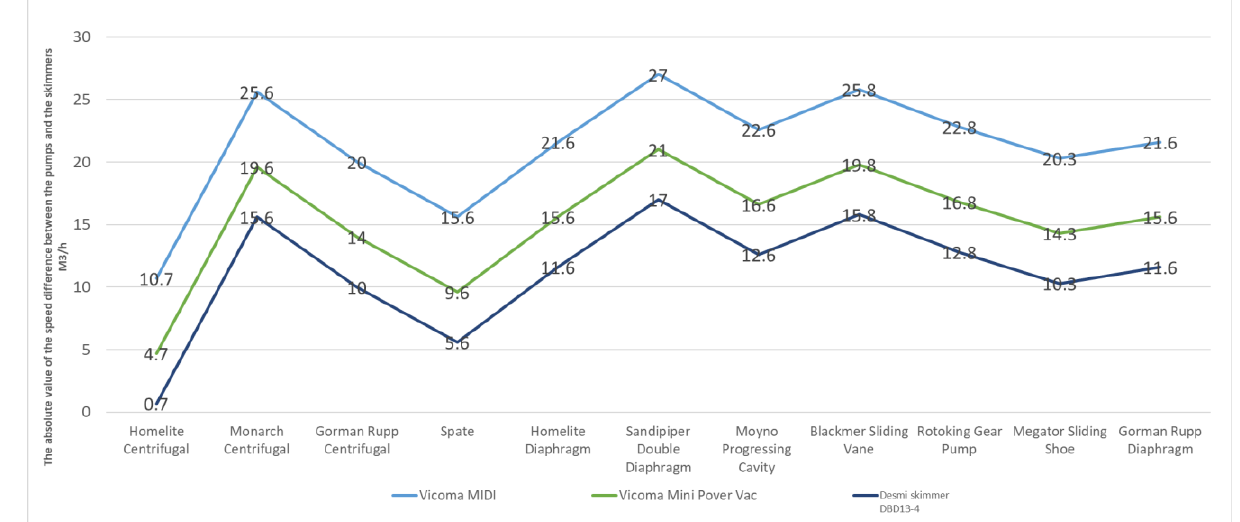
Figure 10 . The speed difference of oil collection between the pumps and the skimmers: Vicoma MIDI, Vicoma Mini Pover Vac, and Desmi DBD13-4.